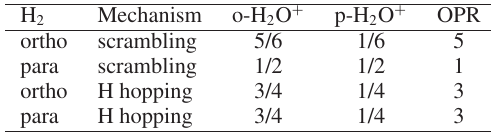
Table 1. Fractions f of ortho- and para-H 2 O + produced from OH + and o- and p-H 2 . H 2 Mechanism o-H 2 O + p-H 2 O + OPR ortho scrambling scrambling 1/2 1/2 1 ortho H